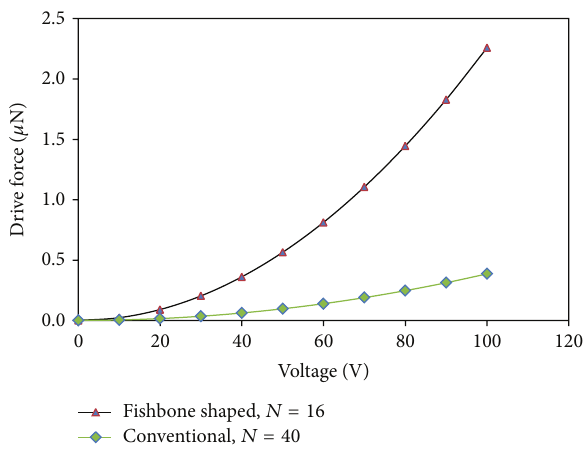
Figure 12: The relationship between driving voltage and electro- static force exerted on the comb fingers in 𝑥 -direction for both multiple fingers of straight conventional comb driver and fishbone shaped comb driver.